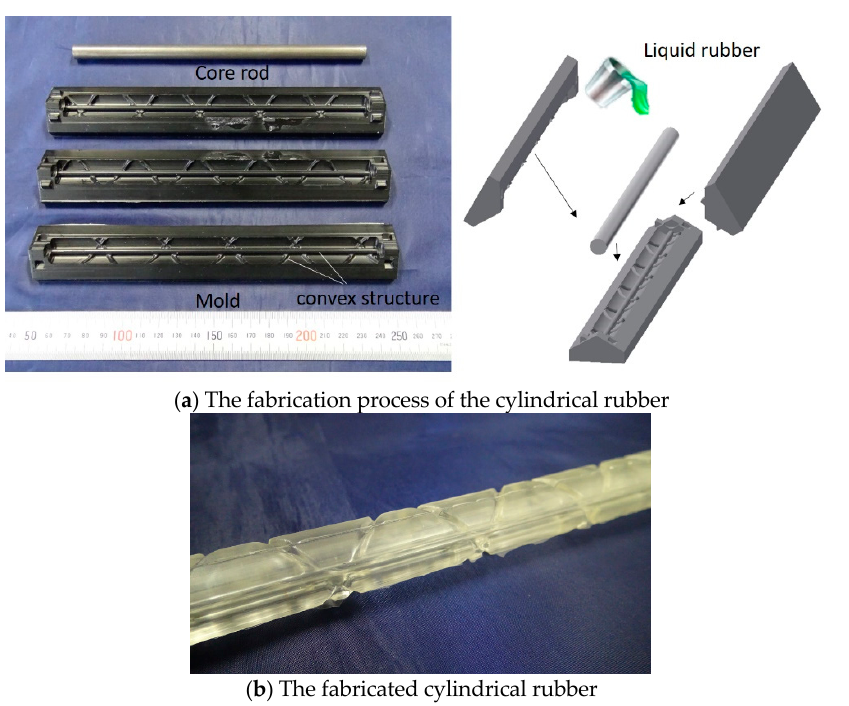
Figure 6. ( a ) The fabrication process of the hollow cylindrical rubber with molds. ( b ) The fabricated hollow cylindrical rubber.